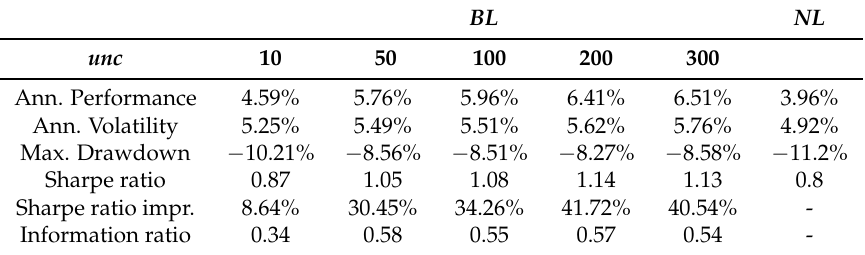
Table 4. Statistics for BL strategies with different values of unc and NL as defined in the workflow. The Sharpe ratio improvement is relative to NL . BL NL unc 10